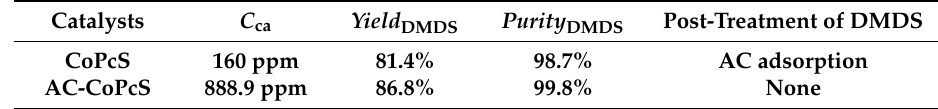
Figure 5. The unseparated DMDS product (upper layer) after the catalytic oxidation reaction using ( a ) free CoPcS and ( b ) AC-CoPcS catalysts. Experimental conditions: SMM (18.0 wt%) 450 g, RR = 600 r/min, free CoPcS dosage 160 ppm, AC-CoPcS dosage 888.9, t = 60 min, T re = 65 ◦ C, P (O 2 ) = 0.9 MPa. Table 2. The performance comparison between free CoPcS and AC-CoPcS catalysts 1